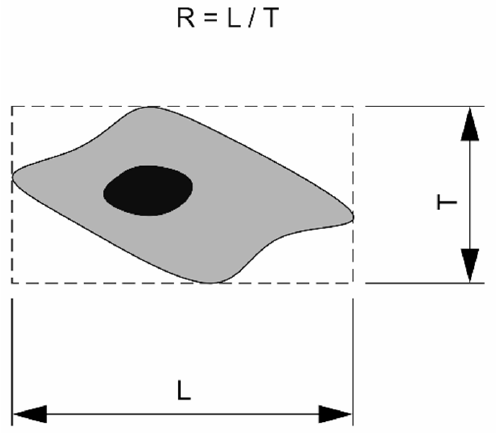
Figure 22. Measurement of the aspect ratio (R) of a